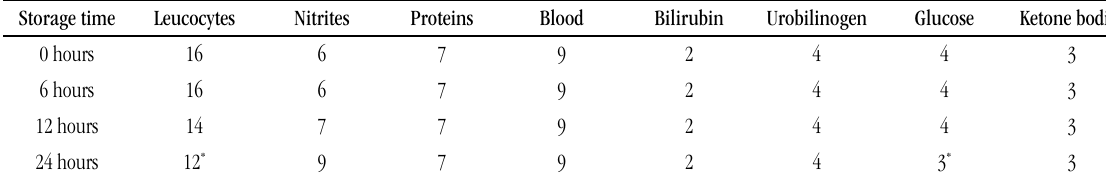
tABLE 2 – Absolute number of positive findings from non-refrigerated urine samples (time zero) kept at room temperature (6, 12 and 24-hours after collection) in chemical analysis by reactive strips